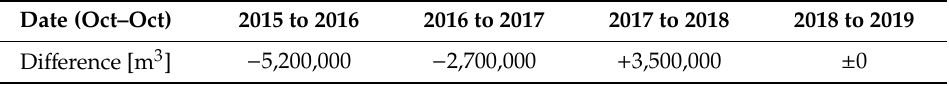
Figure 12. Long section along 5 km of revetment at Chauhali Tangail with scour development along the apron during the first four years after construction (2016 to 2019) (image updated from [15]). Table 4. Annual sediment movement along the 5 km long revetment at Chauhali,